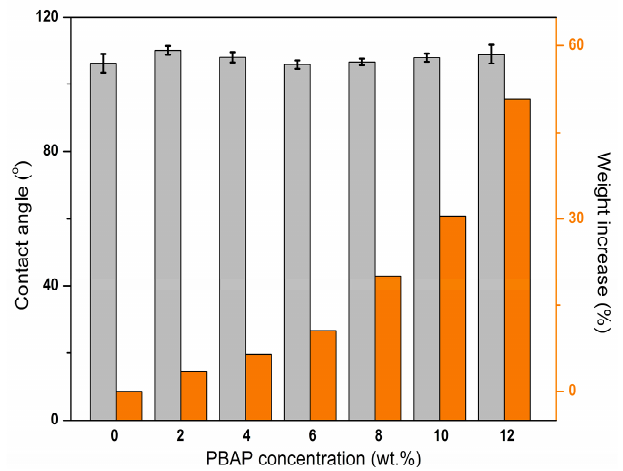
Figure 3. Effect of PBAP concentration on membrane hydrophilicity and weight.